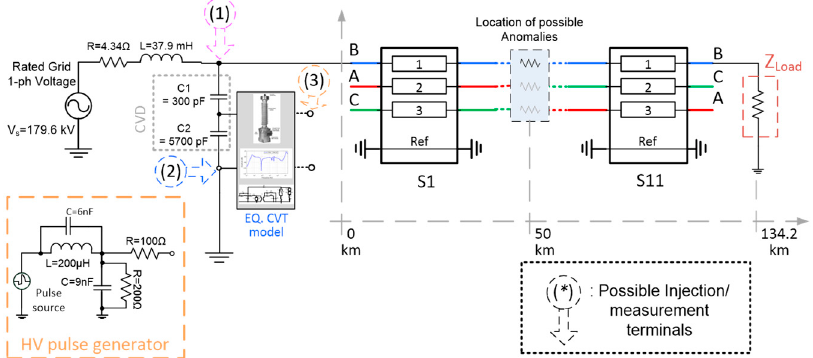
Figure 10. Schematic representation of the circuit setup used for the proposed simulation analysis evidencing the nodes used for the implementation of the three injection/measurement scenarios.